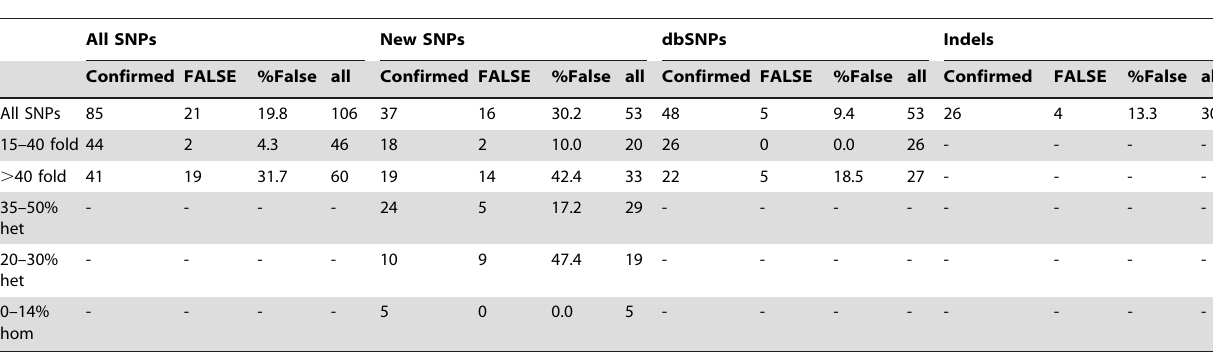
Table 5. SNP validation with Sanger